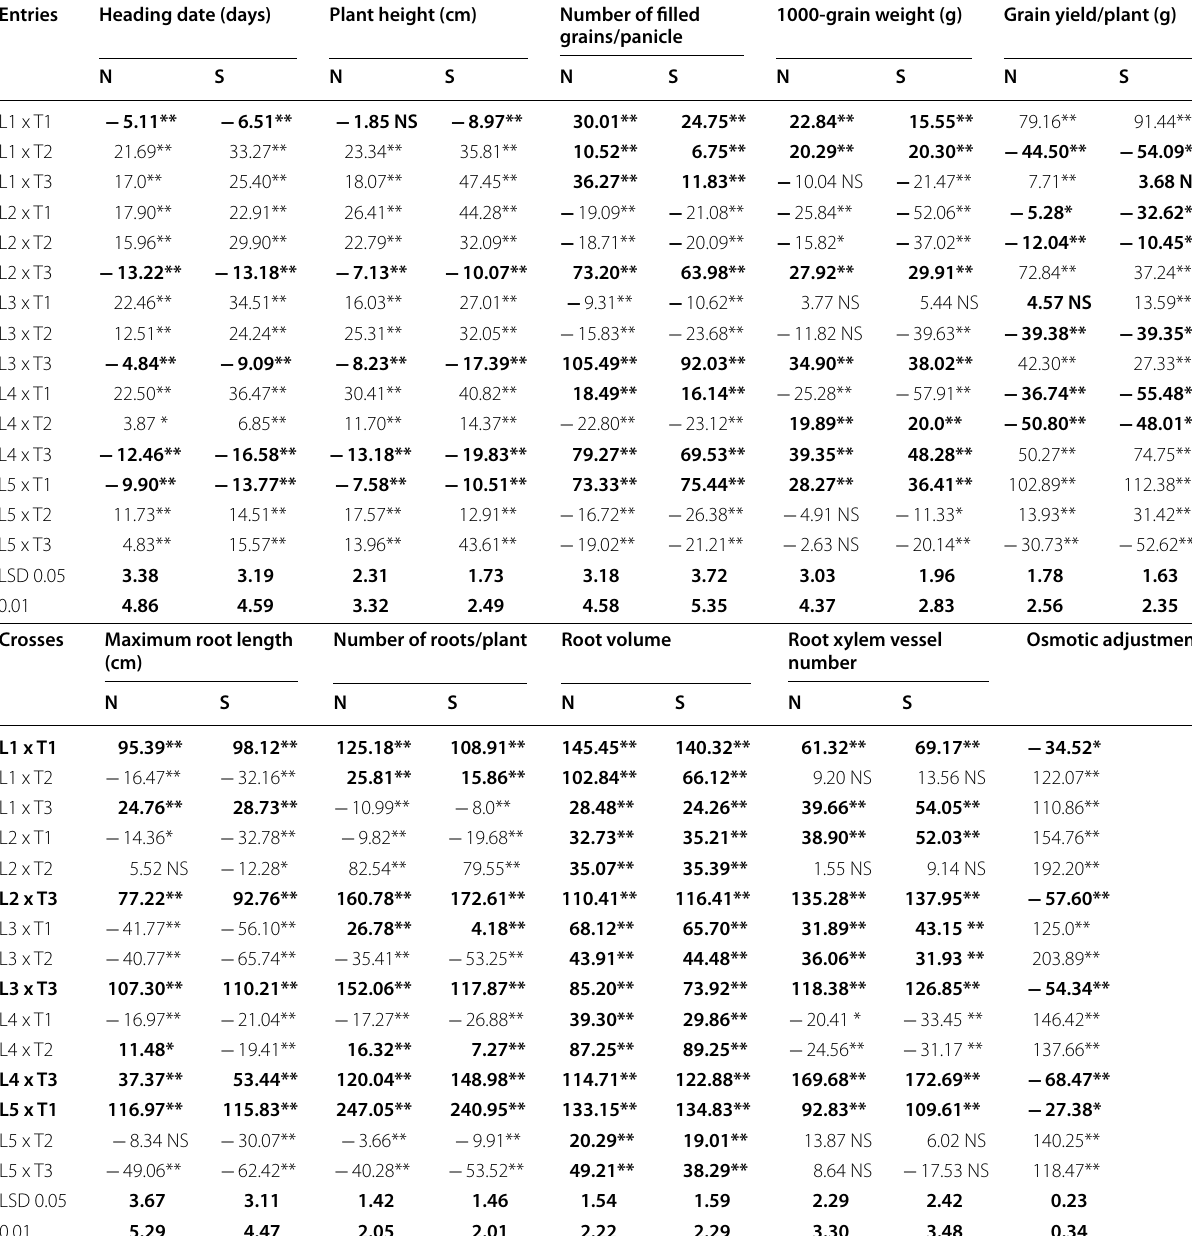
Table 4 Estimates of heterosis over better parent in 15 rice hybrids for all studied traits in both experiments of normal and drought stress